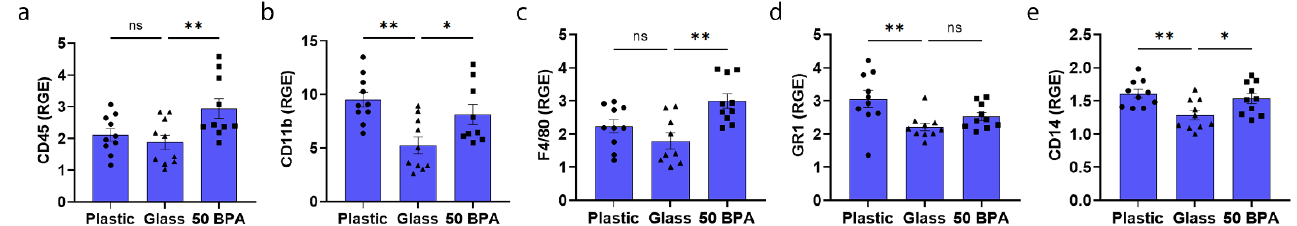
Figure 3. Plastic caging increases macrophage and neutrophil markers during acute myocarditis in BALB/c males. Male BALB/c mice were given normal drinking water (drinking water that did not contain BPA) for 2 weeks and housed either in glass cages/water bottles (glass) or plastic cages/water bottles (plastic) with soy-free food and bedding. BALB/c mice were housed in glass cages/water bottles with soy-free food and bedding and administered either normal drinking water (drinking water that did not contain BPA) (glass) or 250 μ g BPA/L water (50 BPA) for 2 weeks. Mice were injected i.p. with 10 3 PFU of CVB3 on day 0 and harvested at day 10 pi. Relative gene expression (RGE) of whole hearts by qRT-PCR was used to assess ( a ) CD45 (total lymphocytes), ( b ) CD11b+ cells (i.e., macrophages, neutrophils, mast cells), ( c ) F4/80+ macrophages, ( d ) GR1 (neutrophils), ( e ) CD14 (part of the TLR4 signaling complex), compared to the housekeeping gene Hprt. Data shown as scatter plot and mean +/−SEM using one-way ANOVA with Holm –Šídák’s multiple comparisons test with 9 – 10 mice/group (* p < 0.05), (** p < 0.01).